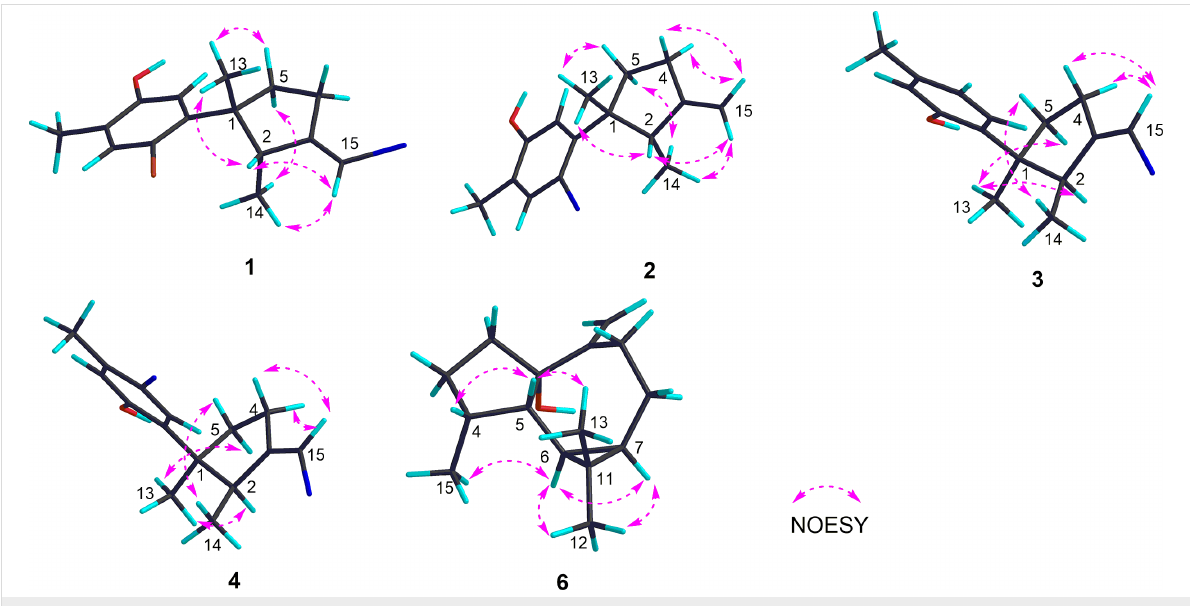
Figure 3: Key NOESY correlations for compounds 1 – 4 and 6 .